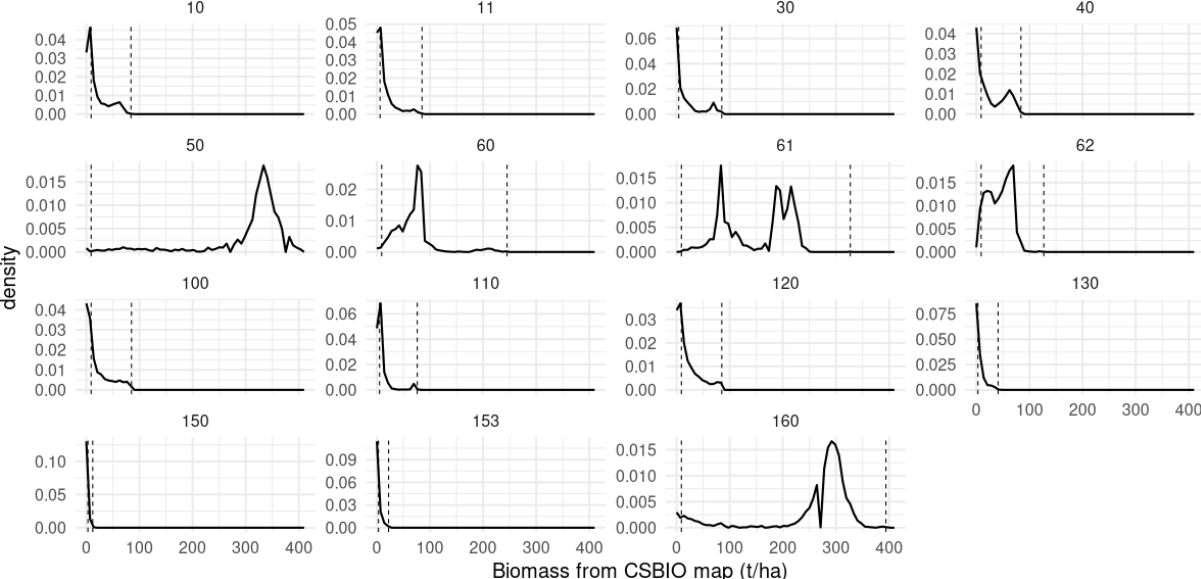
Figure 2. Probability density distribution of the pure land cover pixel for biomass concentration Bp p for 15 selected land cover types. The dashed line represents the 97.5th percentile used as the prior estimate for the reference biomass concentration for trees Bref lc , w . The dashed line represents the 50th percentile also used as the prior estimate for the reference biomass for herbaceous